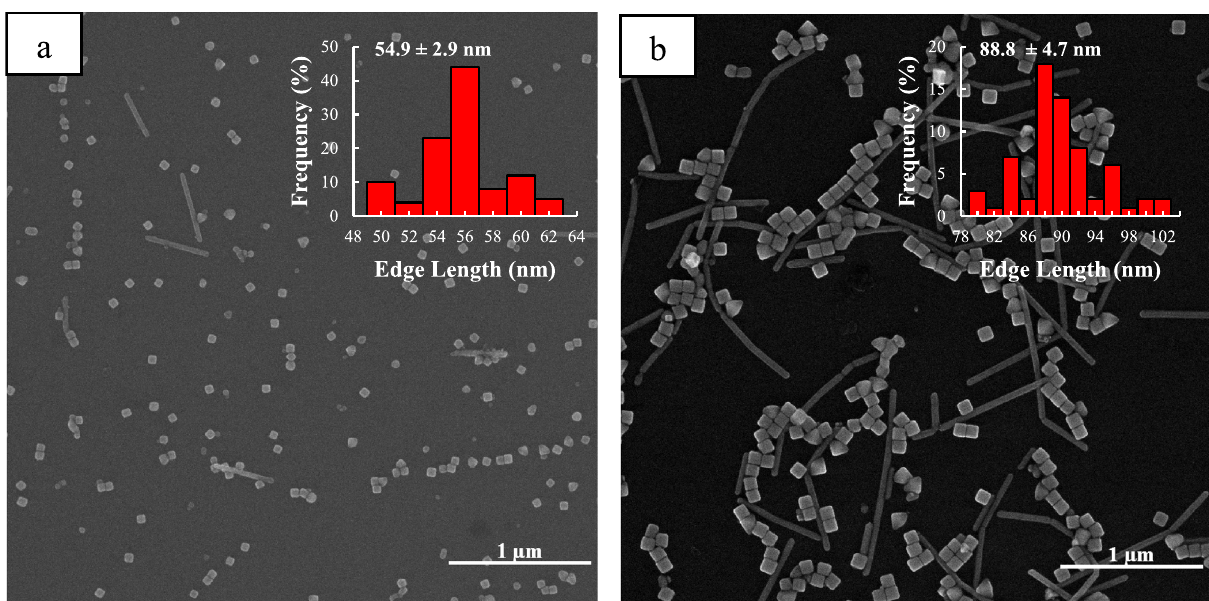
Figure 5. SEM images of Ag nanoparticles obtained under irradiance with excitation wavelength of 465 nm at different reaction times, ( a ) 15 min, ( b ) 90 min. The insets show the size distribution of the Ag